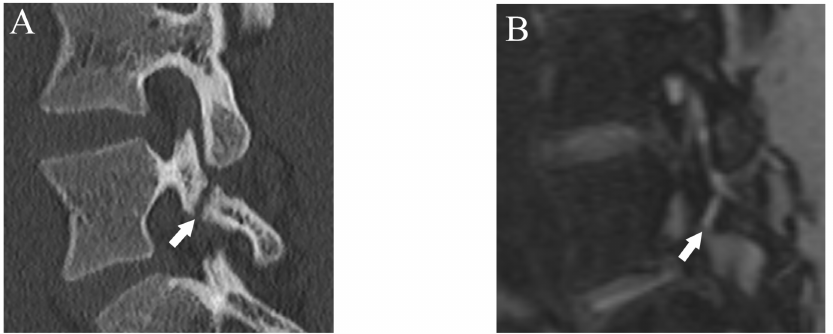
Figure 2. Representative images of grade 2 fracture. The left pars interarticularis of L5 from a 16-year-old male. ( A ) Sagittal CT image showing an incomplete but clear fracture line starting from the caudal part of the pars interarticularis (arrow). ( B ) Sagittal DESS image showing a linear high signal that suggests the fracture line (arrow).